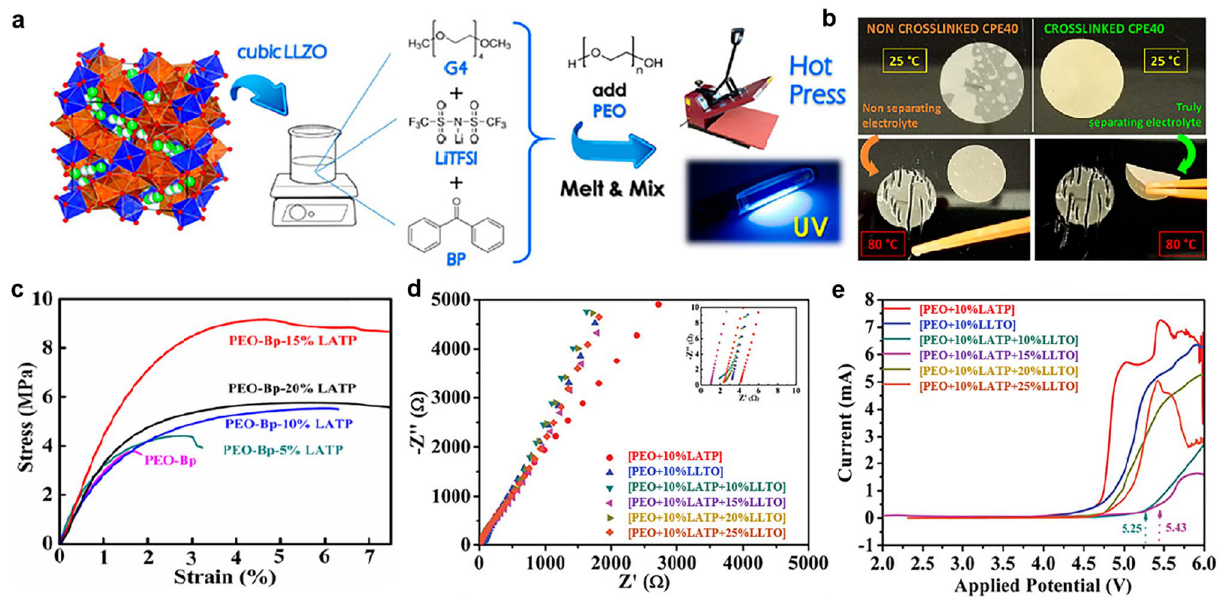
Fig. 8 a Schematic illustrations of the preparation process for CSE membranes via UV irradiation. b The difference in terms of mechanical integrity between non-cross-linked and cross-linked CSEs after impedance test at thermal stress. a, b Reproduced with permission [154]. Copy- right 2019, American Chemical Society. c Stress–strain curves for PEO-Bp and PEO-Bp-LATP membranes. Reproduced with permission [156]. d Impedance-spectra and e linear sweep voltammetry (LSV) curves of polymer gel CSEs. d‑e Reproduced with permission [155]. Copyright 2019,